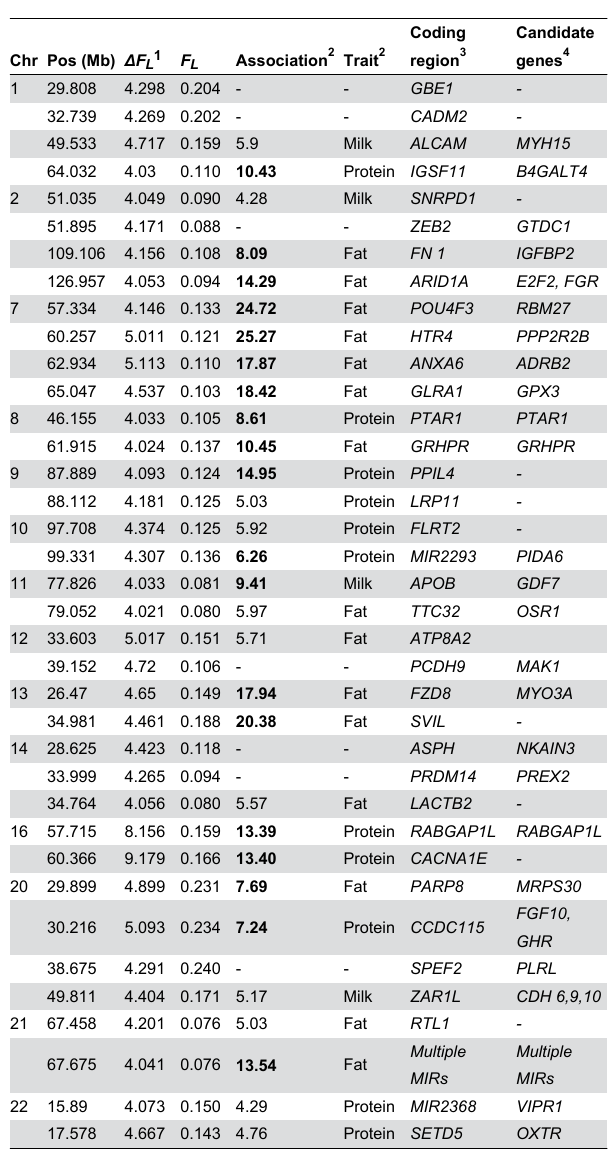
Table 3. Comparison between ΔF haplotype-trait association in Group